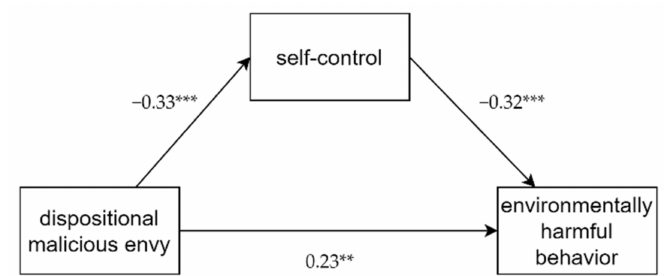
Figure 1. Mediating effect of self-control on DMB and environmentally harmful behavior. *** p < 0.001, ** p < 0.01.